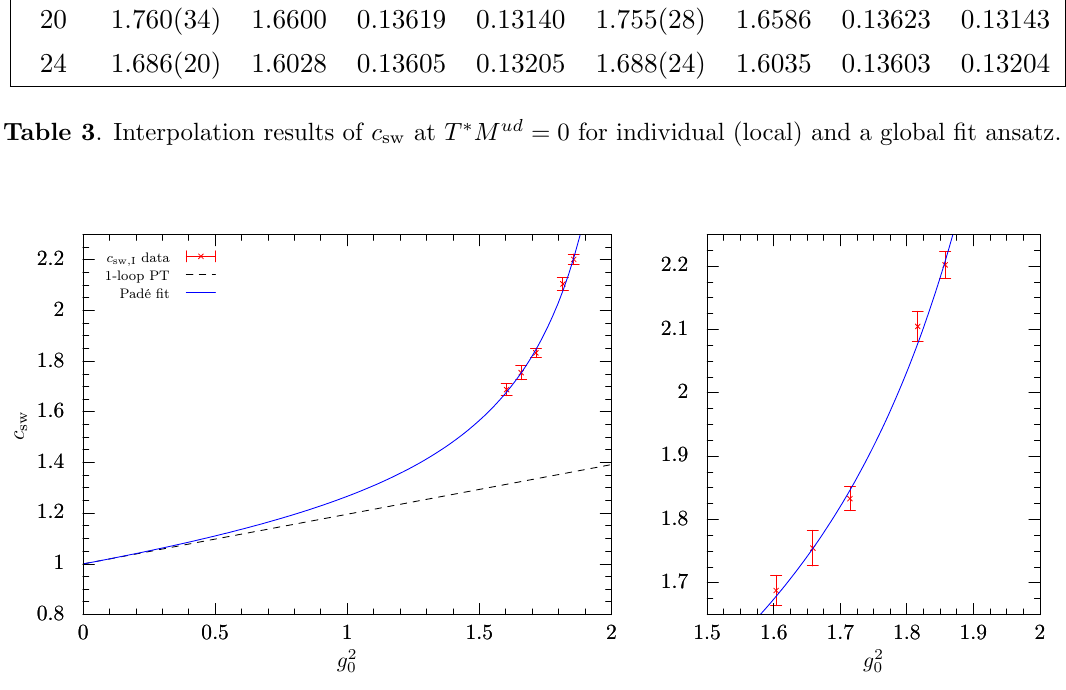
Figure 2 . c sw ; I from global (cid:12)t result as a function of the bare gauge coupling g our line of constant physics.